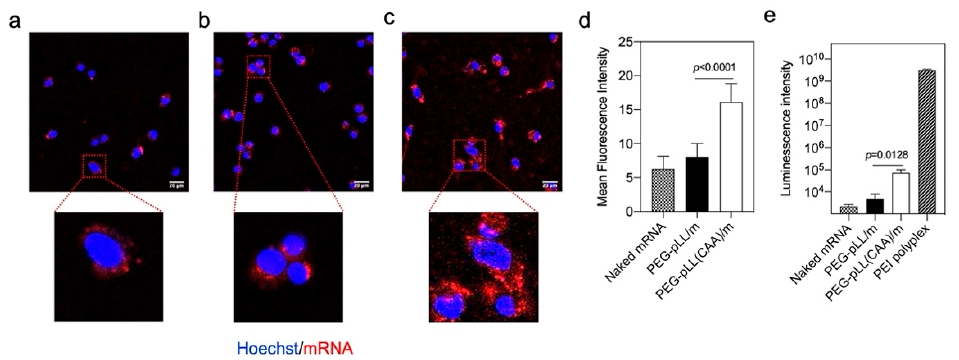
Figure 3. In vitro performance of micelles. Fluorescence in cultured CT26 cells with ( a ) naked Cy5- labeled mRNA, ( b ) PEG-pLL/m and ( c ) PEG-pLL(CAA)/m loading Cy5-labeled mRNA for 6 h incu- bation in medium, observed by confocal laser scanning microscopy (CLSM). Scale bars: 20 µm. ( d ) Cellular uptake efficiency was quantified from the mean fluorescence intensity of the pixels corre- sponding to Cy5 ( n = 30 cells). ( e ) Efficiency of gluc protein expression in CT26 cells after 24 h incu- bation in CT26 cells. Data were expressed as mean ± s.d. ( n = 3). Statistical significance was calcu- lated by the two-tailed Student’s t -test.